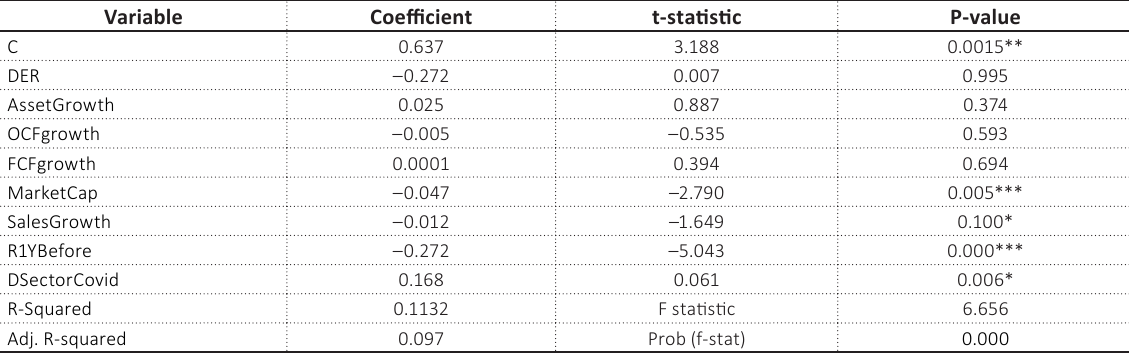
Table 4. Regression model 1 results